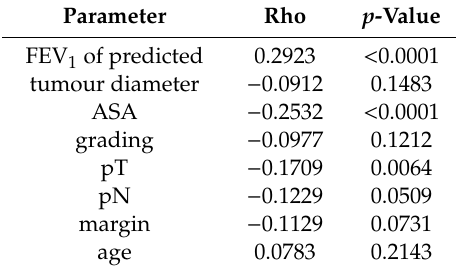
Table 5. Univariable and multivariable prognostic analysis using Cox’ proportional hazard model.